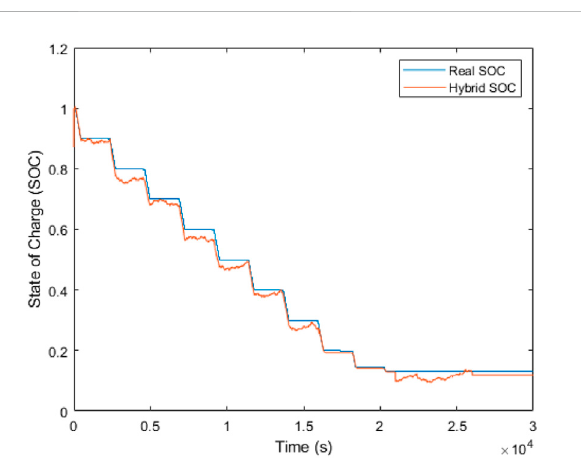
FIGURE 10 Response of the EKF under INR 18650.